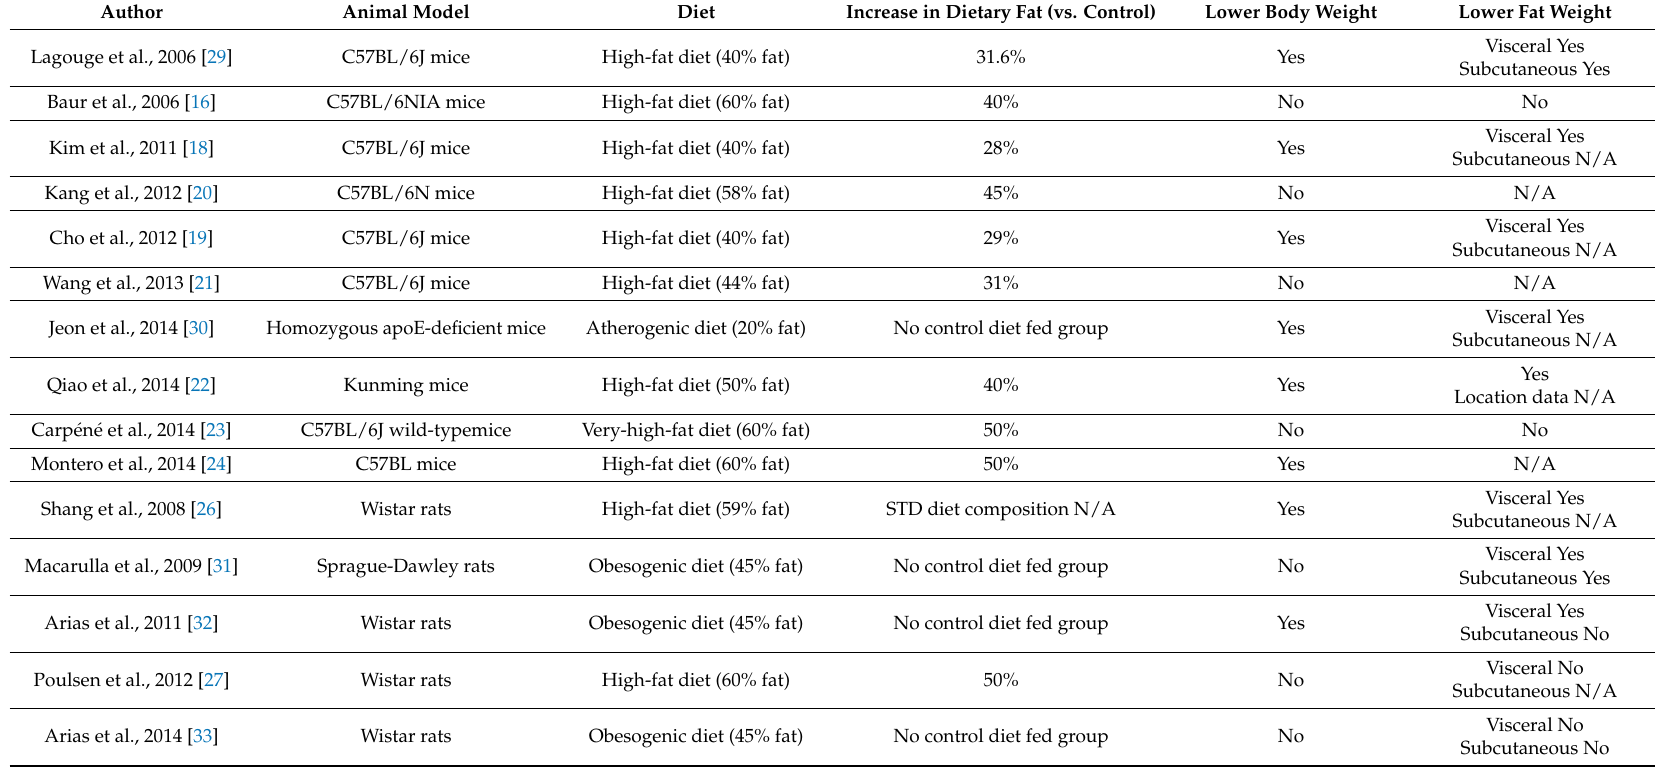
Table 1. Preclinical studies performed administering resveratrol under overfeeding